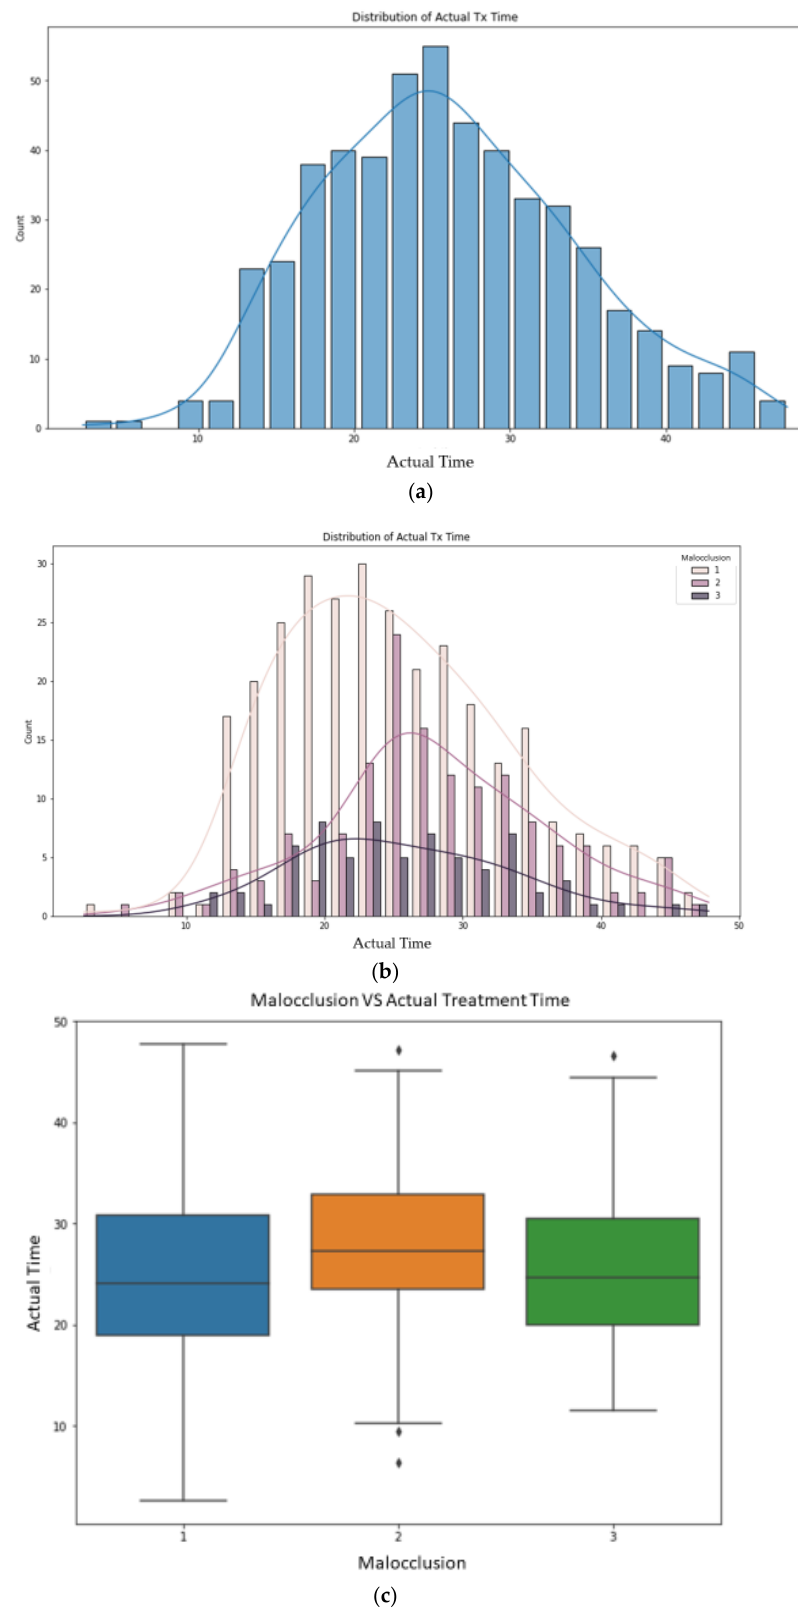
Figure 2. Histograms showing ( a ) actual treatment time distribution and ( b ) actual treatment time based on malocclusion class. Boxplot showing ( c ) malocclusion versus actual treatment time. The correlation between the variables shown in Figure 3 revealed that the overbite and overjet values were highly correlated (0.43). In addition, both maxillary and mandib- ular crowding values were highly correlated (0.51). All other pairs did not show signifi- cant correlations.